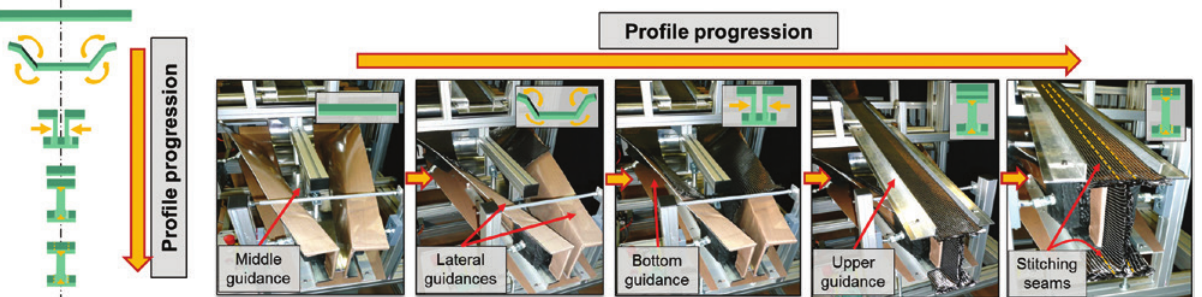
Figure 8: Schematic (left) and processing sequence (right) of the Continuous Profile Preforming System (CPPS). Source: Institut für Verbundwerkstoffe